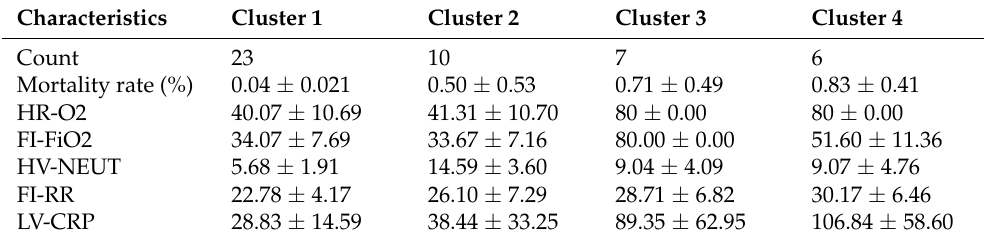
Table 4. The results of the performed updated SHAP clustering to generate a mortality risk stratifica- tion